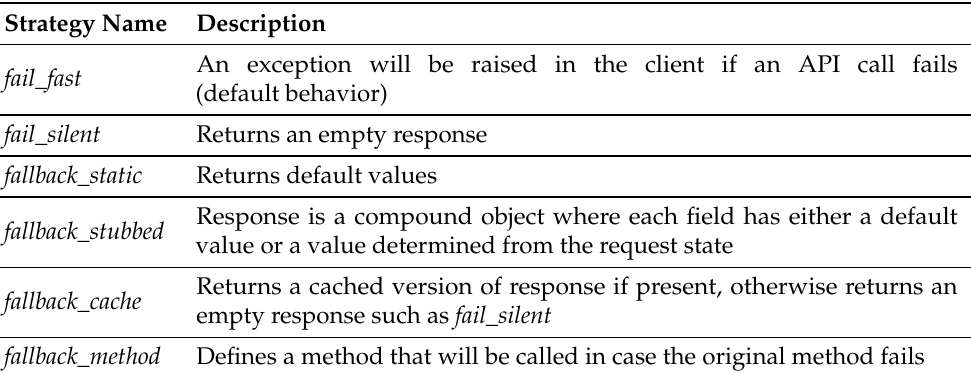
Table 9. Failure recovery strategies supported by